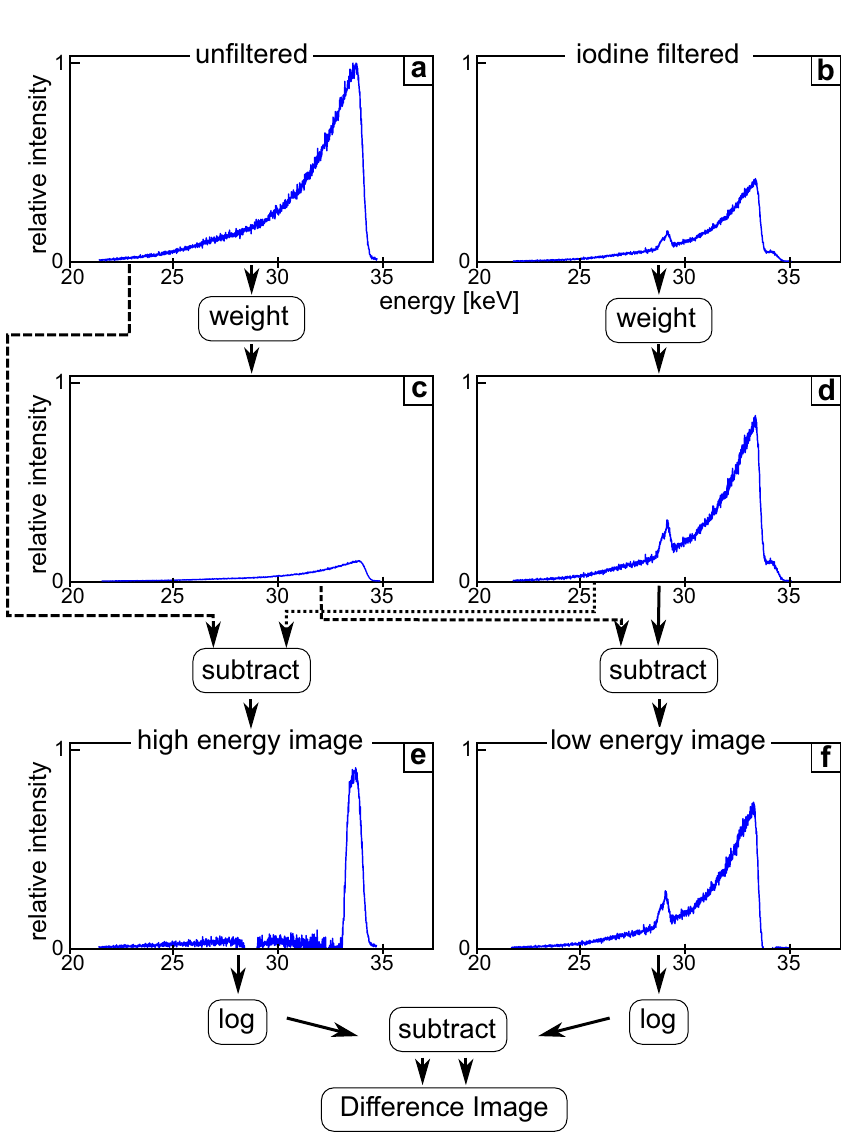
Fig 2. Workflow used for calculating a K-edge subtraction image at the MuCLS. First, unfiltered and iodine-filtered images are recorded and dark current, flatfield and flux corrected. To obtain two images only containing the high- or low-energy part of the spectrum, one needs to eliminate the high-energy part in the iodine filtered image and the low- energy part in the unfiltered image. The iodine-filtered image is weighted so that its intensity corresponds to the low- energy part of the unfiltered image, which results in the weighted iodine-filtered image (d) . Subtracting image (d) from the unfiltered image (a) , the high-energy image (e) is obtained, as the low-energy parts of the spectra are identical and fall away in the subtraction. To obtain the low-energy image, the high-energy part of the weighted iodine-filtered image has to be eliminated. Therefore, the unfiltered image (a) is weighted so that it corresponds to the remaining high-energy part of the weighted iodine-filtered image. The weighted unfiltered image (c) is then subtracted from the weighted iodine-filtered image (d) , yielding a low-energy image (f) , where the high-energy contribution is completely cancelled out. Finally, the difference image is obtained by logarithmically subtracting the low-energy image from the high-energy one. weighted iodine-filtered spectrum Fig 2D, producing a low-energy spectrum Fig 2F where the high-energy part of the spectrum is completely canceled out: